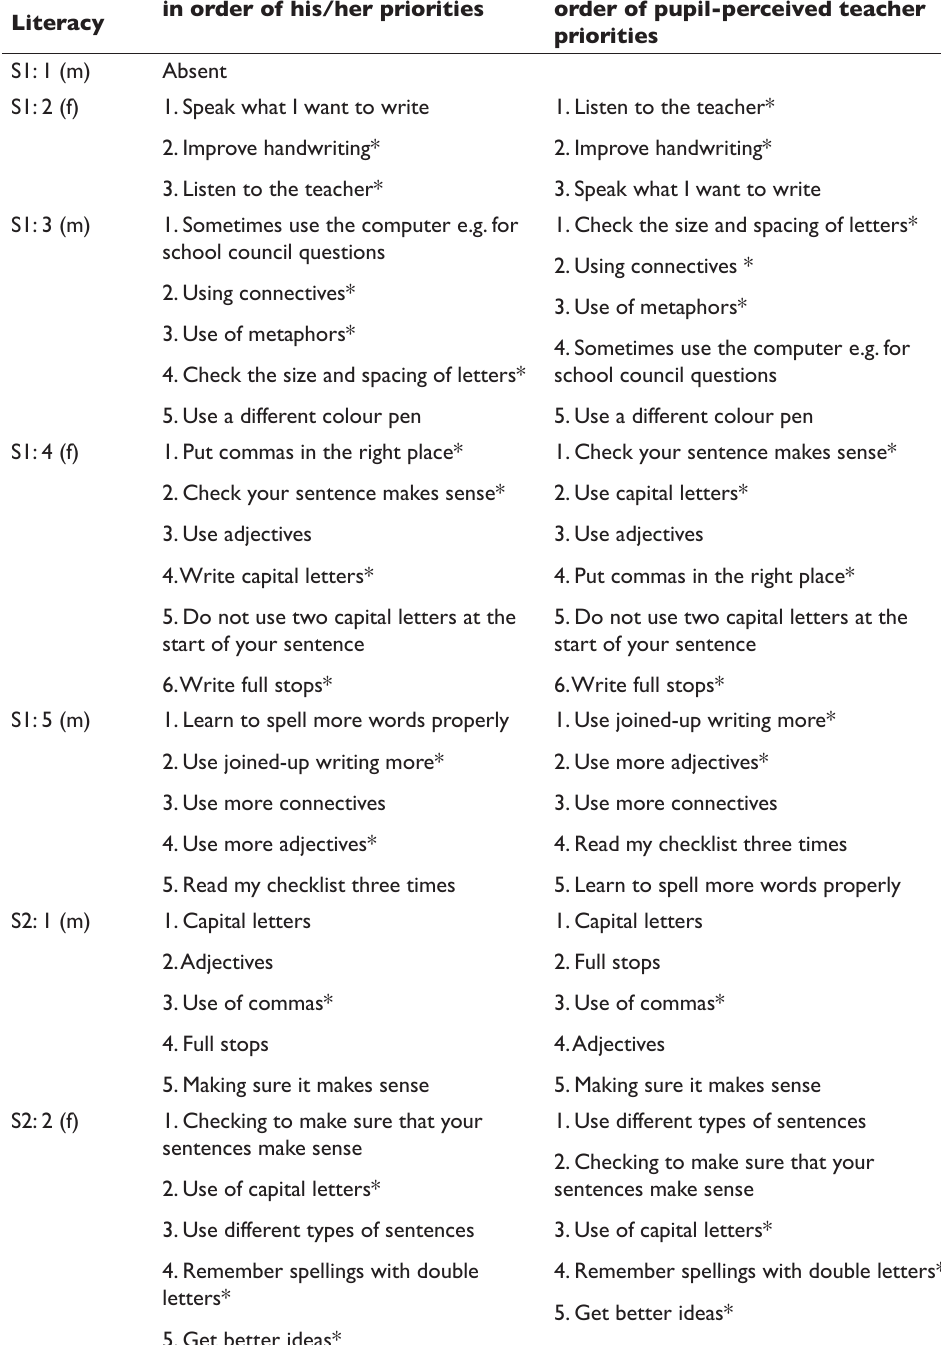
Table 2: Learning targets for literacy Session 2: Targets sequenced by the pupil in order of his/her priorities Literacy